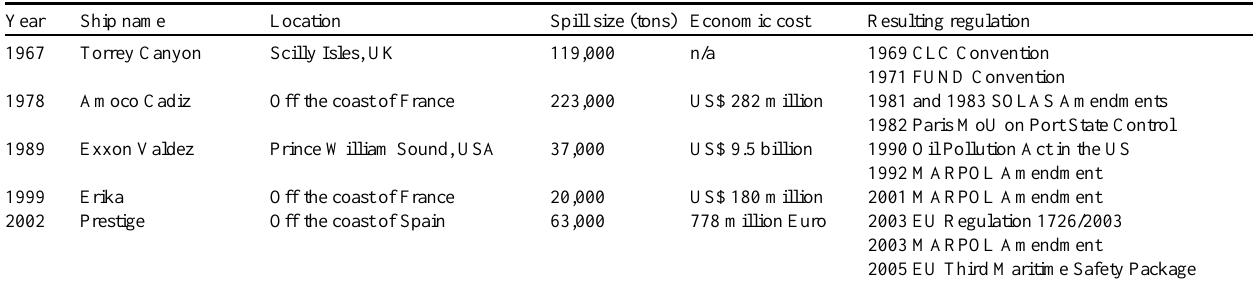
Table 5 . Selected marine oil spills and development of mandatory regulations relevant to oil tankers,